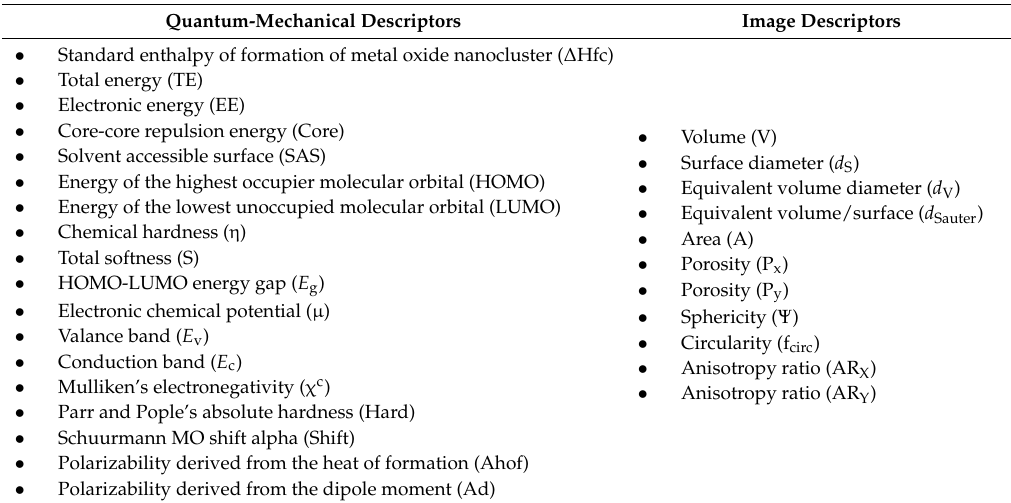
Table 4. Overview of quantum-mechanical and image descriptors of 18 metal oxide ENMs, as retrieved from the study by Gajewicz et al.